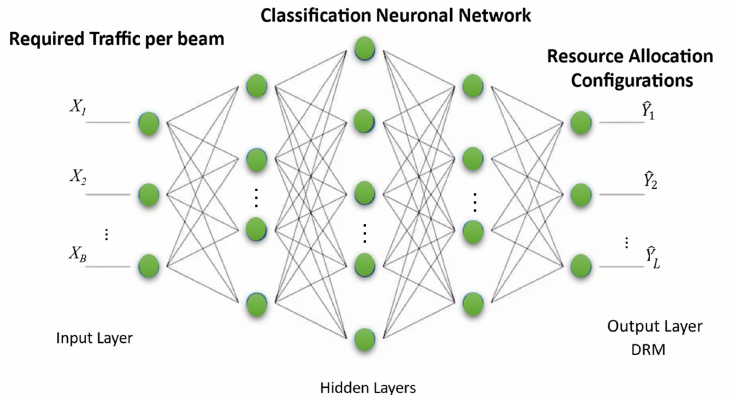
Figure 4. Deep neural network (DNN) to manage power and bandwidth